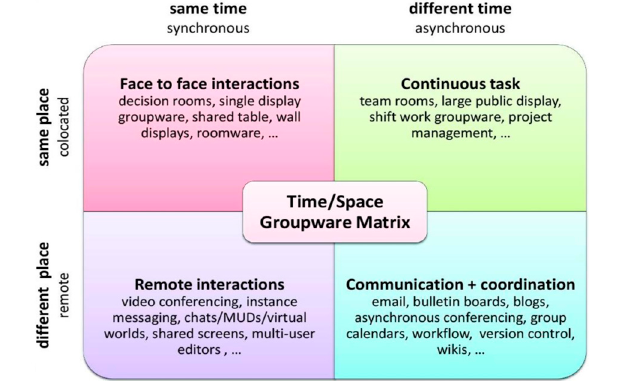
Figure 1. Computer-supported cooperative work (CSCW) matrix [3] (p. 7).